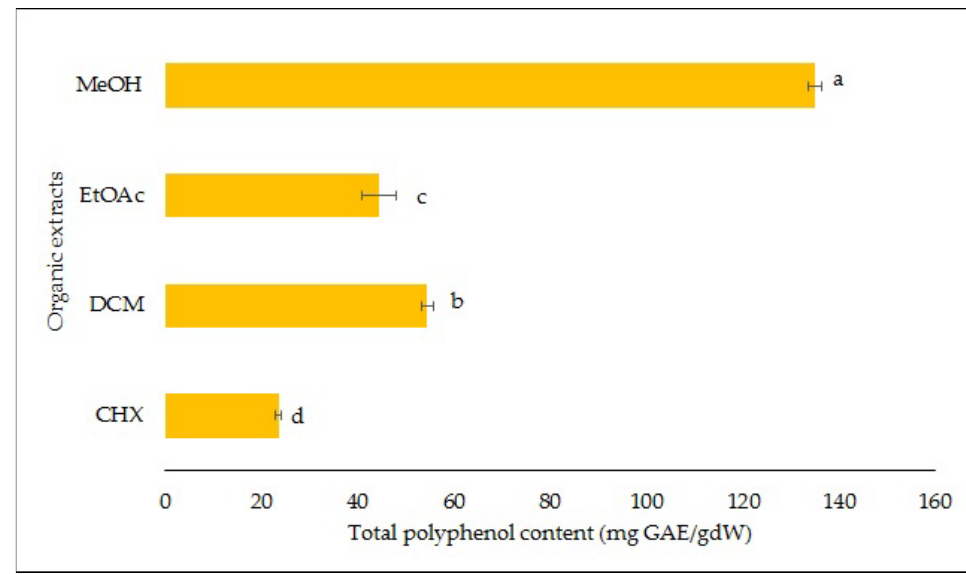
Figure 2. Total polyphenol content. Results are means ± standard deviations of four independent analyses. Different letters indicate significantly different means at p < 0.05 .